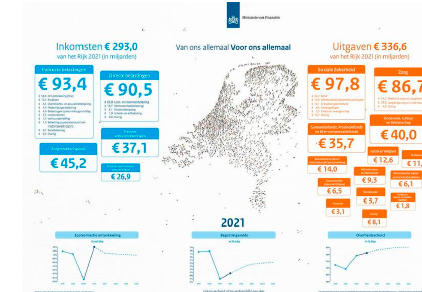
Figure A1. Infographic overview of externalities in energy production.